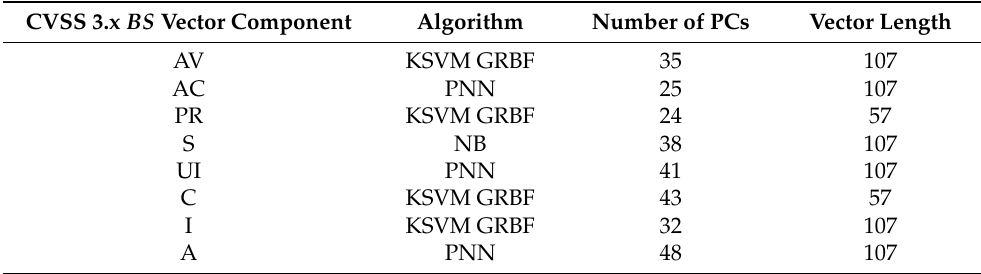
Table 4. Assignment of machine learning algorithms to the classification of the components of the CVSS 3.x base vector with the number of PCs and the length of the training vectors. CVSS 3.x BS Vector